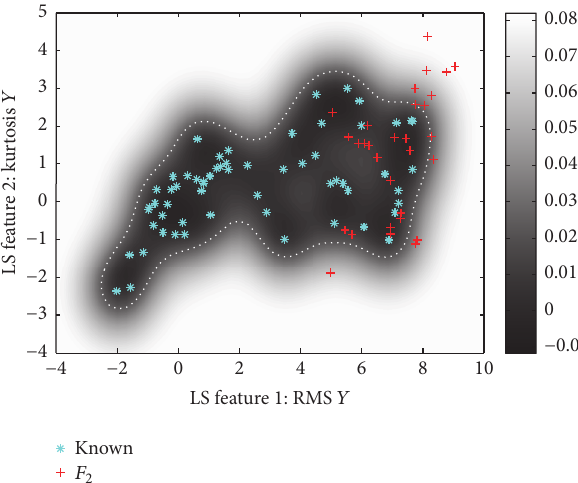
Figure 6: Evaluation of the fault scenario 𝐹 1 . The novelty model is trained employing data from healthy operation condition.